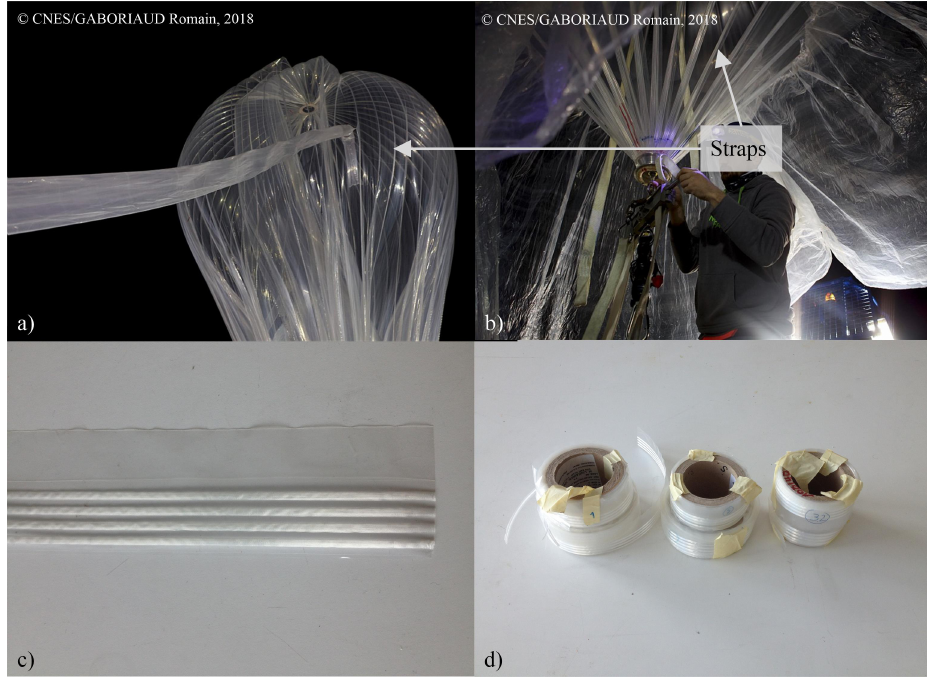
Figure 1. ( a ) Envelope of a stratospheric balloon. ( b ) Focus on strap assembly on the load ring. ( c ) Strap. ( d ) Different specimens of straps made on the balloon production line for the study.